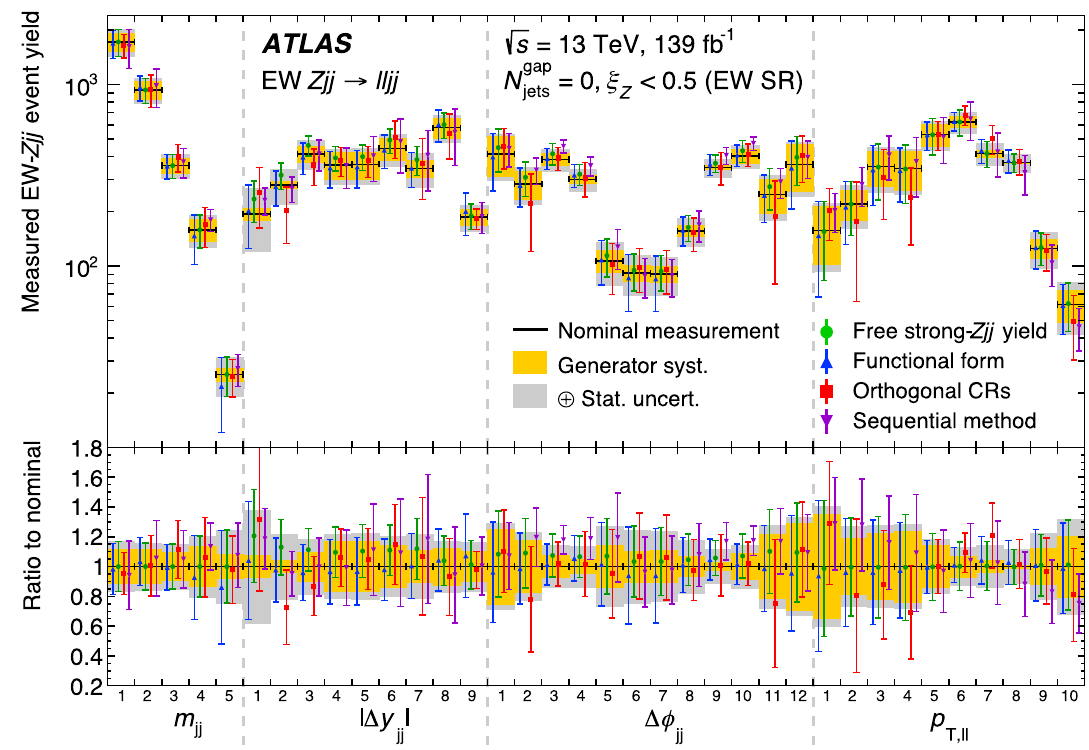
Fig. 12 Extracted EW Zjj event yields in bins of the four observables measured using five different methods. The nominal measurements with their associated uncertainties are shown as bands, while the measurements based on the four variations to the EW Zjj extraction methodology are shown as points with error bars corresponding to their associated total uncertainty (excluding the experimental systematics, that tend to be significantly smaller)